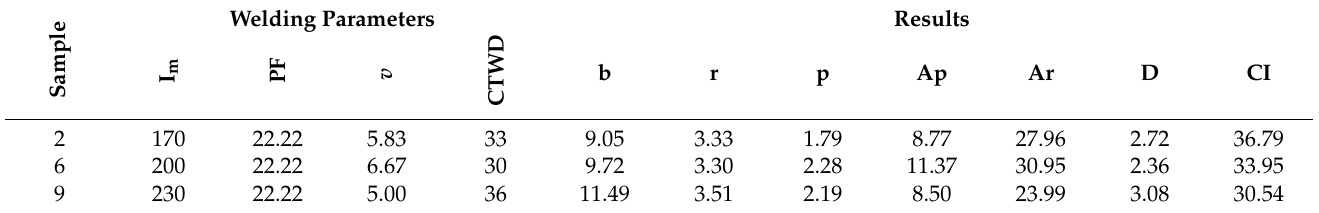
Table 5. Results of weld bead morphology with pulsed current. Where: I m , average current (A); PF, pulse frequency (Hz); 𝑣 , welding speed (mm·s − 1 ); CTWD, contact-tip-workpiece distance (mm); r, reinforcement height (mm); b, bead width (mm); p, penetration depth (mm); Ar, reinforcement